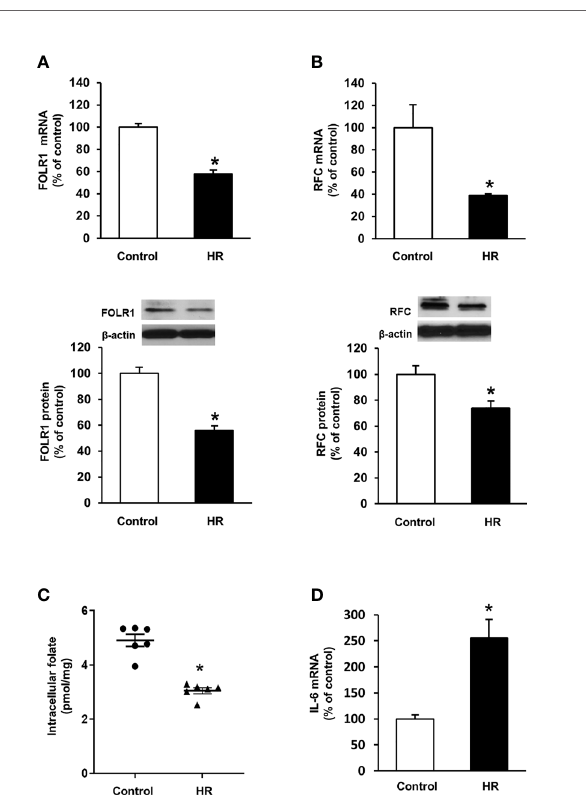
FIGURE 5 | Effect of hypoxia-reoxygenation on folate transporter expression and folate levels in proximal tubular cells. Cells were subjected to 2 h hypoxia followed by reoxygenation (HR) for 48 h or 72 h. The mRNA and protein expression of (A) folate receptor-1 (FOLR-1) and (B) reduced folate carrier (RFC) were determined by real-time PCR analysis 48 h after hypoxia-reoxygenation and by Western immunoblotting analysis 72 h after hypoxia-reoxygenation, respectively. (C) Intracellular folate was measured 72 h after hypoxia-reoxygenation. (D) IL- 6 mRNA was determined. Cells cultured under normal condition were used as control. Results are expressed as mean ± SE (n = 5-6). * P < 0.05 when compared with the value obtained from the control